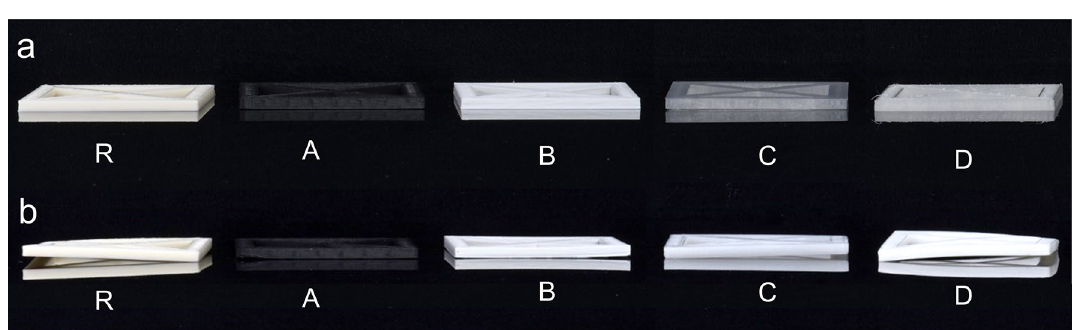
Figure 3. Exemplary visualization of square specimens (R, A–D) after 3D printing ( a ), and after steam sterilization ( b